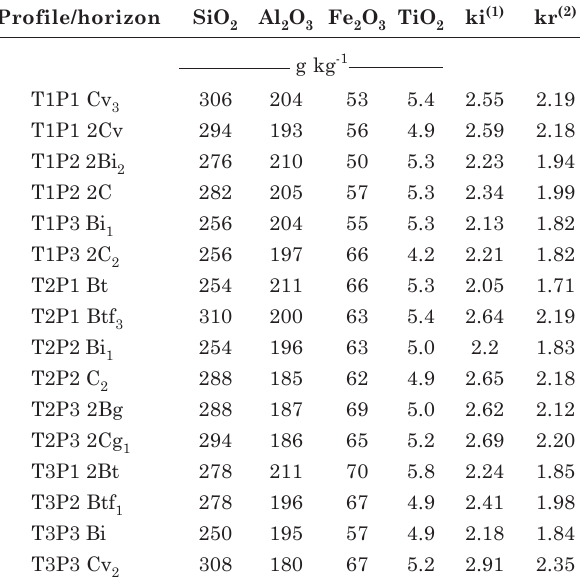
Table 3. Contents of Si, Al, Fe and Ti, determined by sulphuric attack on clay, and molecular ratios ki and kr for the horizons under Profile/horizon